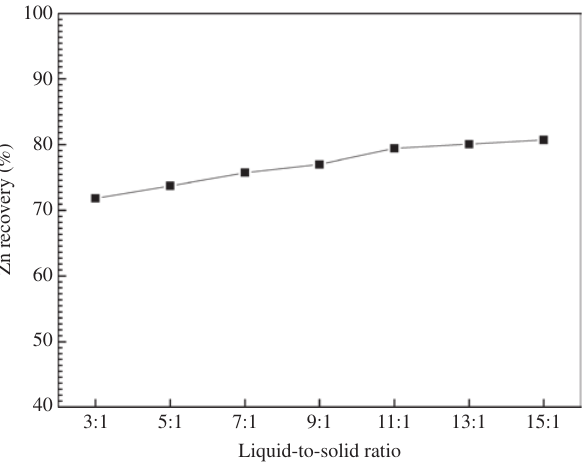
Figure 7: Effects of liquid to solid ratios on zinc recoveries of the roasted